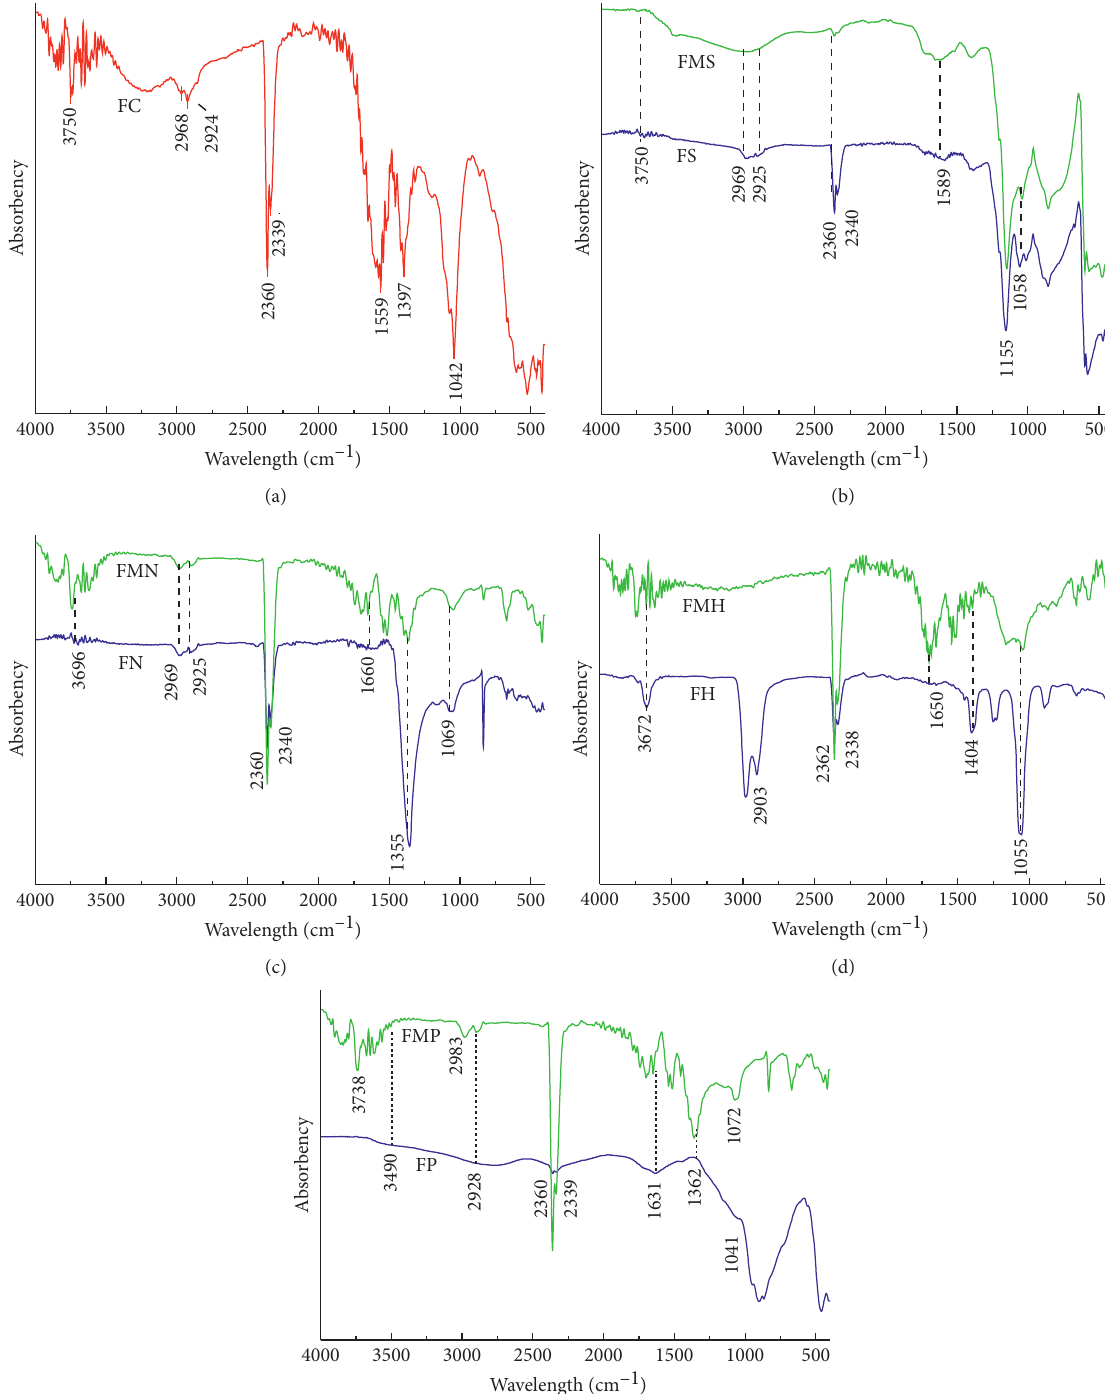
Figure 3: (a) FTIR of fulvic acid. FTIR of fulvic acid by (b) sulfuric acid precipitation, (c) nitric acid precipitation, (d) hydrochloric acid precipitation, and (e) phosphoric acid